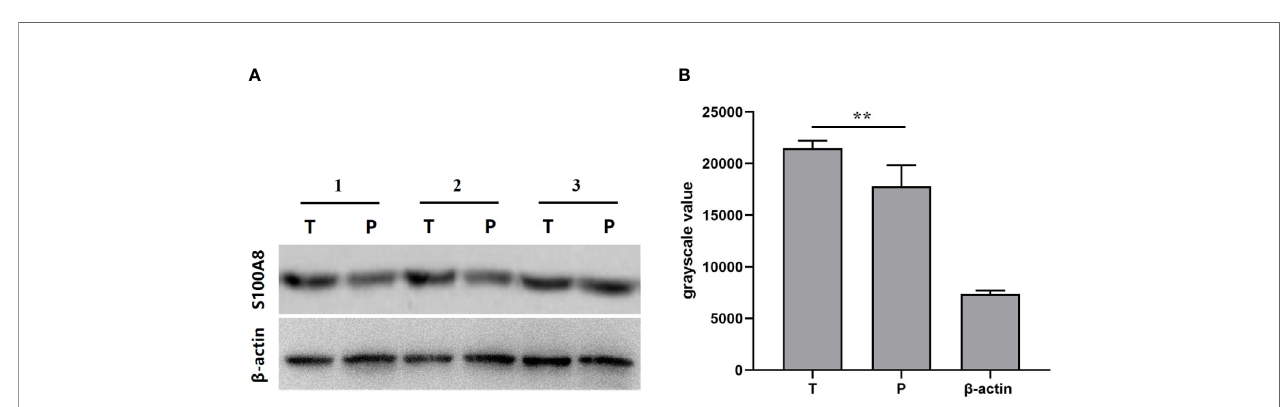
FIGURE 9 | (A) Western blot of paired samples of tumor tissue (T) and para-carcinoma tissue (P) immunoblotted against S100A8 or b -actin (used as a loading control). (B) grayscale value of western blot of paired samples of tumor tissue (T), para-carcinoma tissue (P), and b -actin (n = 8). **means p <